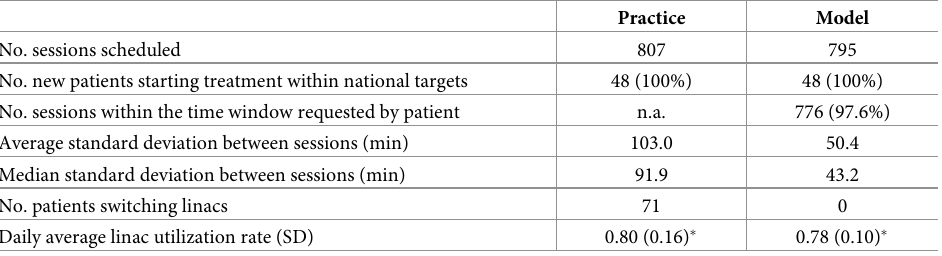
Table 4. Performance comparison between the schedule built manually and the MILP model in the NKI.